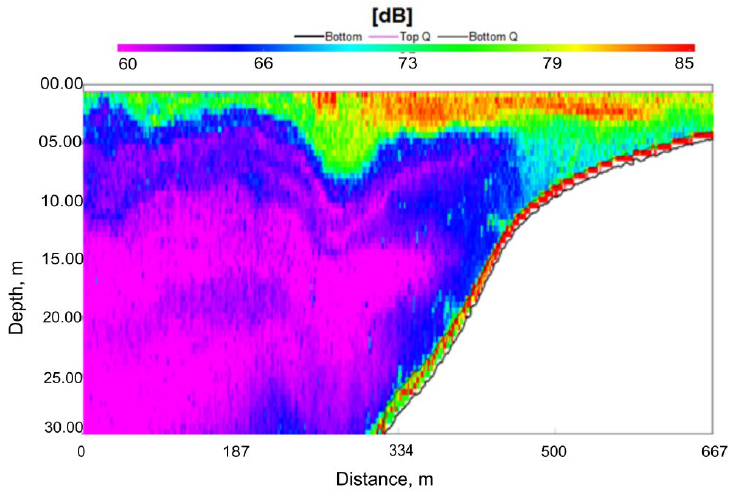
Figure 5. Manifestations of internal waves on the backscattering coefficient on the ship tack near the Kodor River (ADCP record, 20 June 2021).